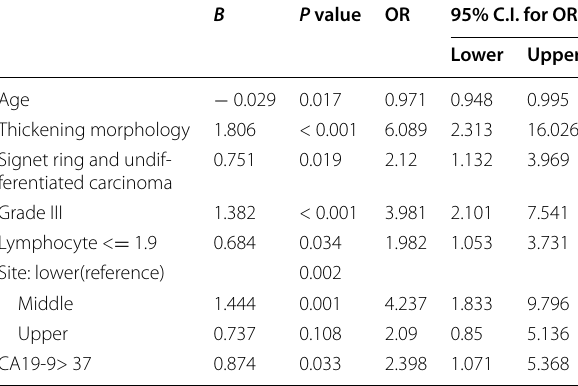
Table 2 Univariate logistic regression